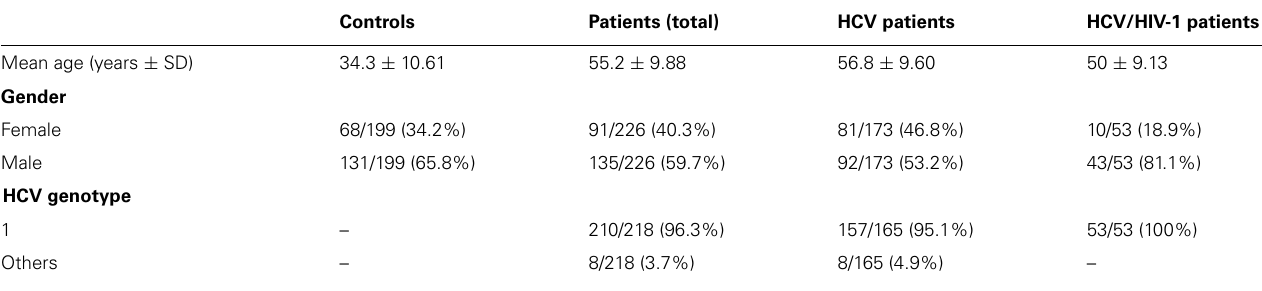
Table 1 | Demographic and virological characteristics of study